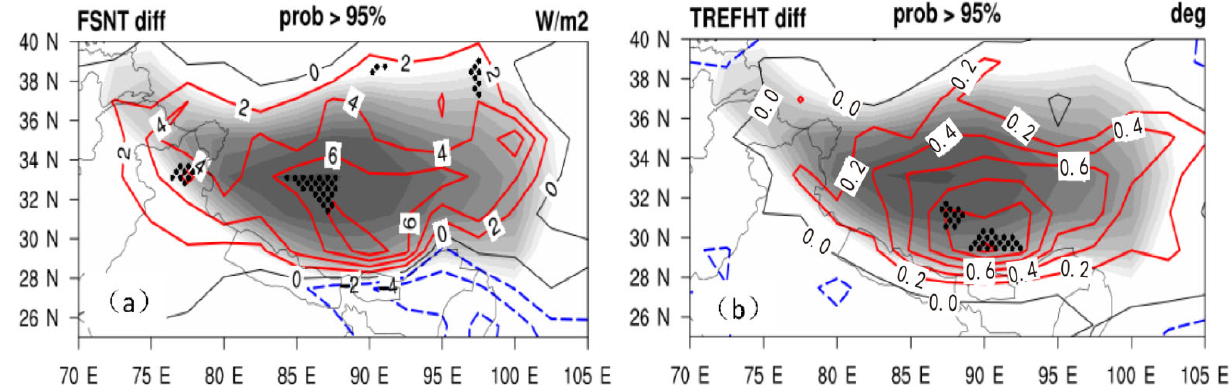
Figure 13. Differences in high and low SA years of ( a ) annual net solar flux (unit: W/m 2 ) at the top of the atmosphere and ( b ) annual temperature (unit: °C) at the reference height. Stippling indicates the grid points that passed the 0.05 significance test, shading indicates plateau areas, solid and red lines represent the isolines greater than zero, and dashed and blue lines represent the isolines less than zero. (Units: latitude is °N, and longitude is °E).